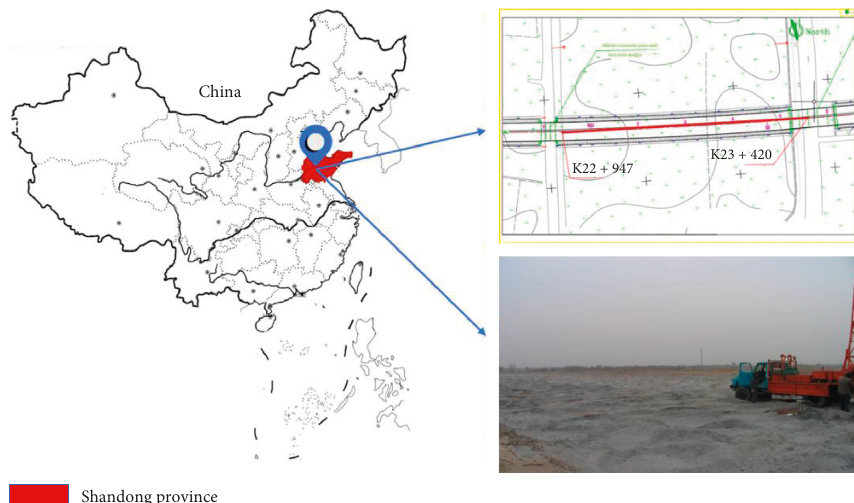
Figure 1: The approximate location of K22 +97 ∼